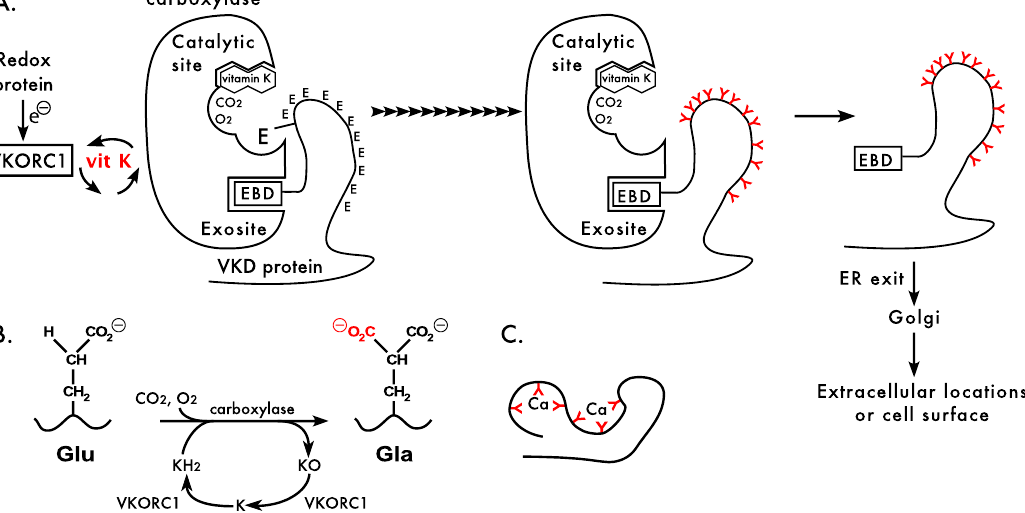
Figure 2. Carboxylation of multiple glutamyl residues generates a calcium-binding module required for vitamin K-dependent protein activities. ( A ) Vitamin K-dependent (VKD) protein carboxylation occurs in the endoplasmic reticulum, where vitamin K (vit K) cycles between reduced vitamin K generated by a vitamin K epoxide reductase (VKORC1) and oxidized vitamin K produced by the carboxylase. VKORC1 becomes inactivated during vitamin K reduction, and activity is regenerated through electron (e − ) flow from a redox protein. VKD proteins are targeted for carboxylation because they contain an exosite binding domain (EBD) that mediates binding to the carboxylase. Multiple Glu residues are carboxylated (arrowheads) to Glas (red Ys). Following carboxylation and release from the carboxylase, the VKD proteins exit the endoplasmic reticulum (ER) and traffic to the Golgi where additional post-translational modifications occur. Further secretion localizes VKD proteins in blood or extracellular matrix or the cell surface. ( B ) The carboxylase uses the epoxidation of vitamin K hydroquinone (KH 2 ) to vitamin K epoxide (KO) to replace a hydrogen in glutamic acid (Glu) residues by CO 2 , forming carboxylated Glu (Gla). KO is then recycled by VKORC1, first to a quinone intermediate (K) and then to vitamin K hydroquinone (KH 2 ). ( C ) Multiple Gla residues (red